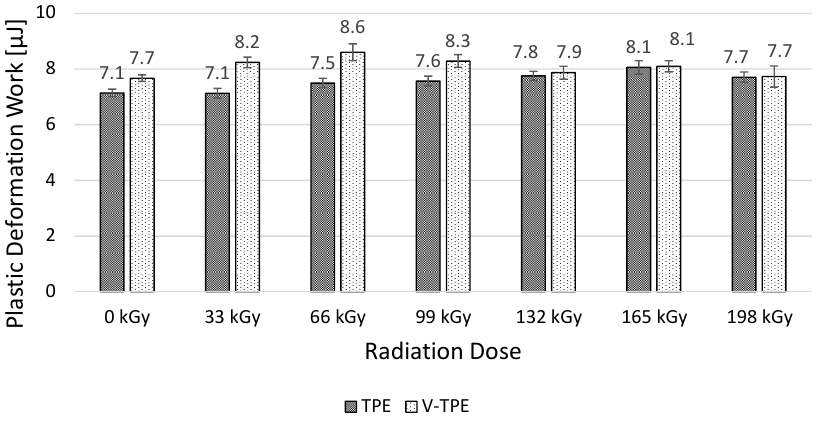
Figure 8. Plastic deformation work—TPE, V-TPE.